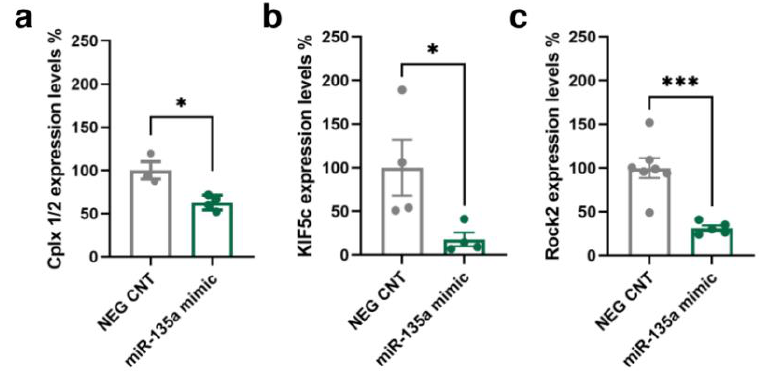
Figure 3. In vitro validation of predicted miR-135a-5p target genes. ( a ) Cplx 1/2, ( b ) Kif5c, and ( c ) Rock2 protein expression in primary neuronal cultures treated with miR-135a-5p mimics. ( a , b ) Mann–Whitney test, * p < 0.05; N = 4 (NEG CNT), 3–4 (miR-135a mimic). ( c ) Student’s t -test, *** p < 0.001; N = 7 (NEG CNT), 5 (miR-135a mimic).